Question: Identify the chart type used in this figure.
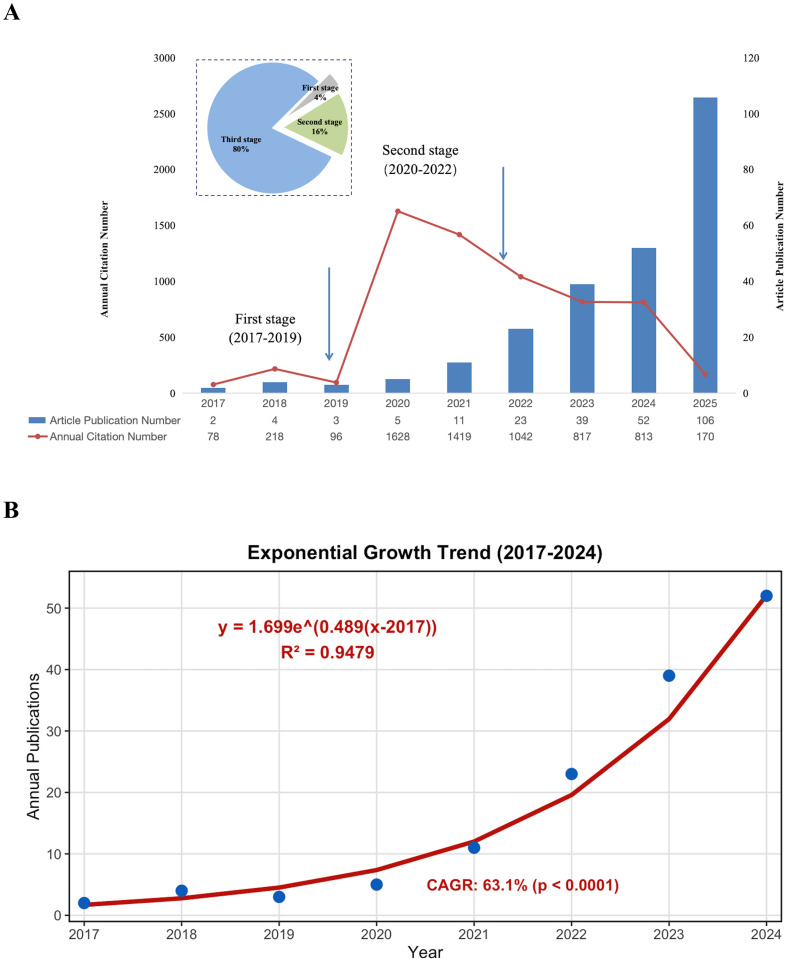
Answer: bar